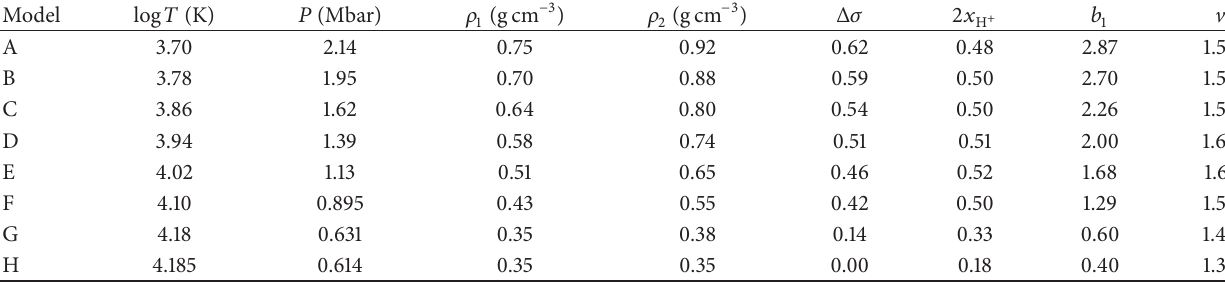
Table 1: Effective temperature for different phase transition points a